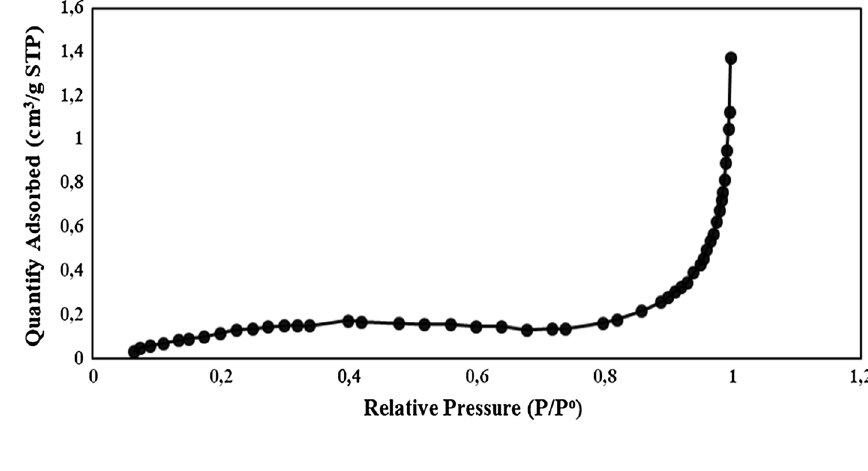
Fig. 3 Pore size distribution of the